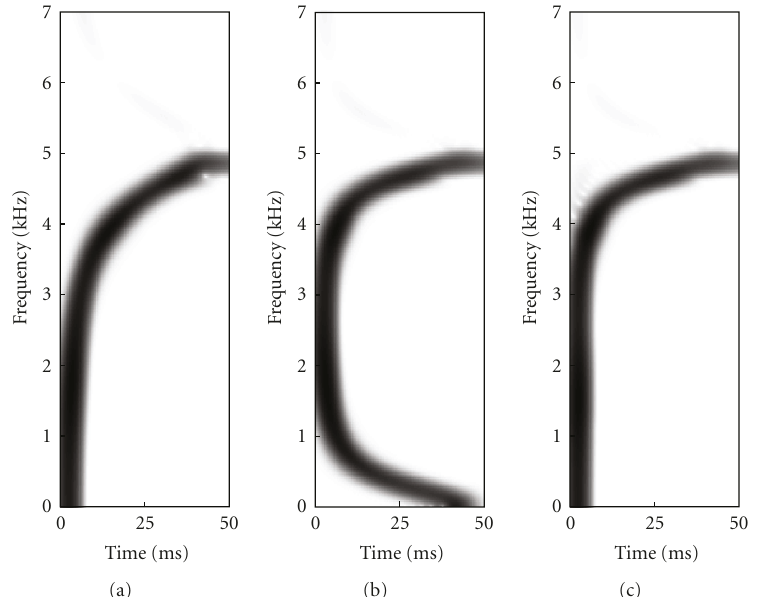
Figure 4: Spectrograms showing (a) a single C lf chirp, produced by the original structure, (b) the modified chirp, and (c) the modified chirp after straightening of the bottom half. All chirps have been low-pass filtered to remove information above the desired f C .